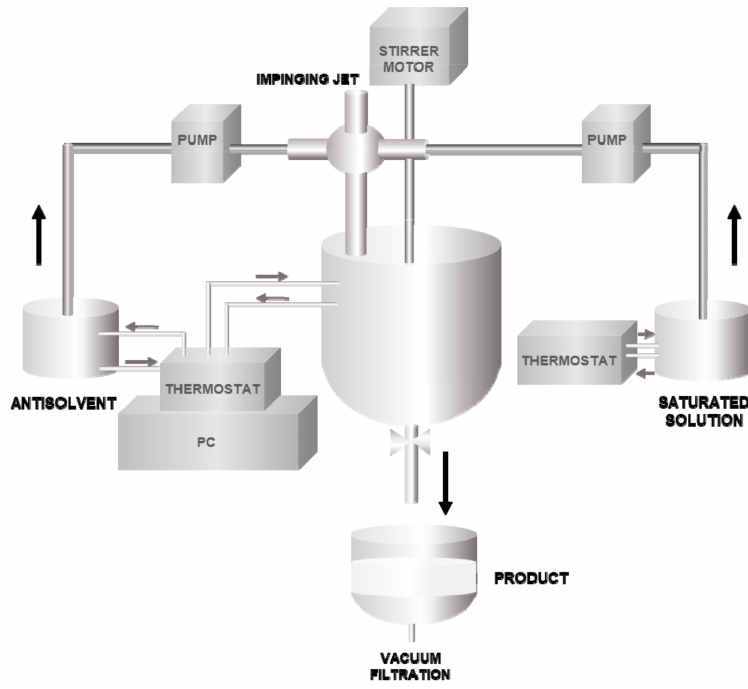
Figure 2. Experimental apparatus of impinging jet